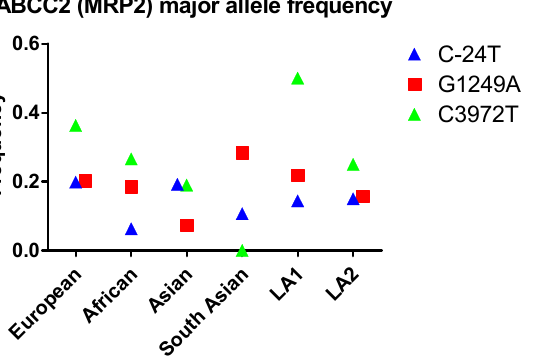
Figure 3. The allele frequency of ABCC2 in different populations. Asian: All Asian individuals excluding South Asians; LA1: Latin American individuals with Afro-Caribbean ancestry; LA2: Latin American individuals with mostly European and Native American Ancestry. Data were extracted from NCBI ALFA project (version: 20200227123210, www.ncbi.nlm.nih.gov/snp/docs/gsr/alfa/